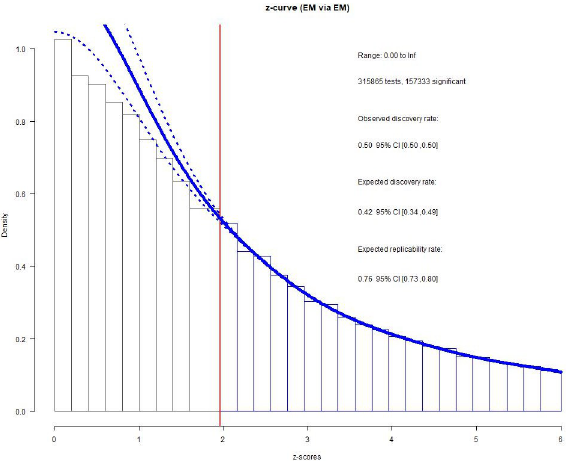
Fig 4. Z-curve results for the non-substantive